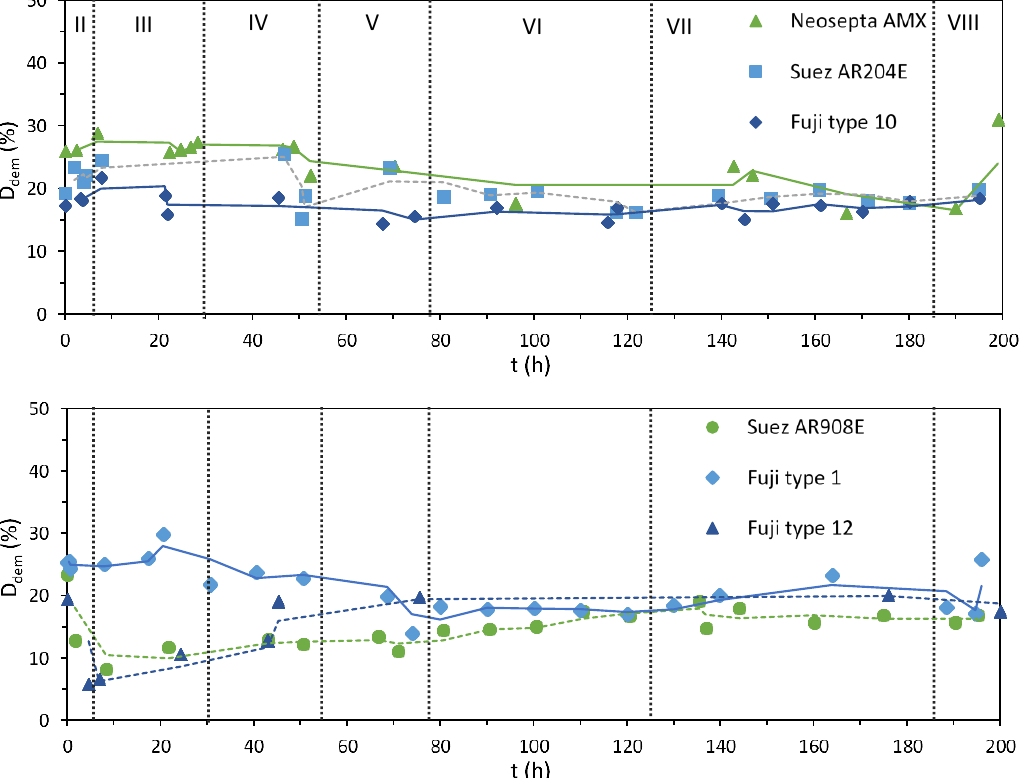
11 of 22 Figure 3. Electric potential U versus time during the EDR runs with stacks containing different AEMs. Chronologically, the experiments were performed in the following order: Neosepta AMX, Suez AR204E, FujiFilm-10, Suez AR908E, FujiFilm-1, and FujiFilm-12. Figure 3 also shows that the measured potential fluctuated differently for each of the stacks. Still, it is possible to identify that the membranes Suez AR204E, Suez AR908E, and FujiFilm-12 coincide in